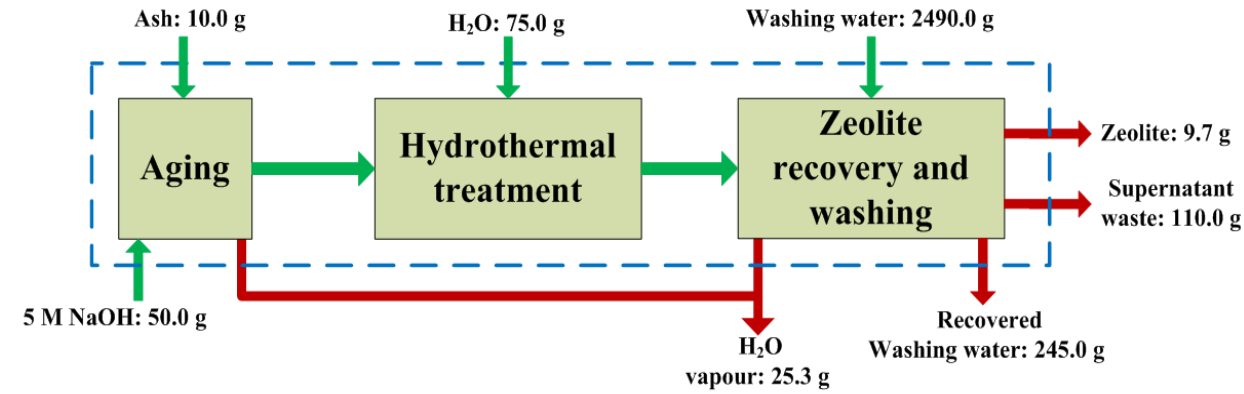
Figure 2. Block flow diagram illustrating the overall mass balance of the 2-step